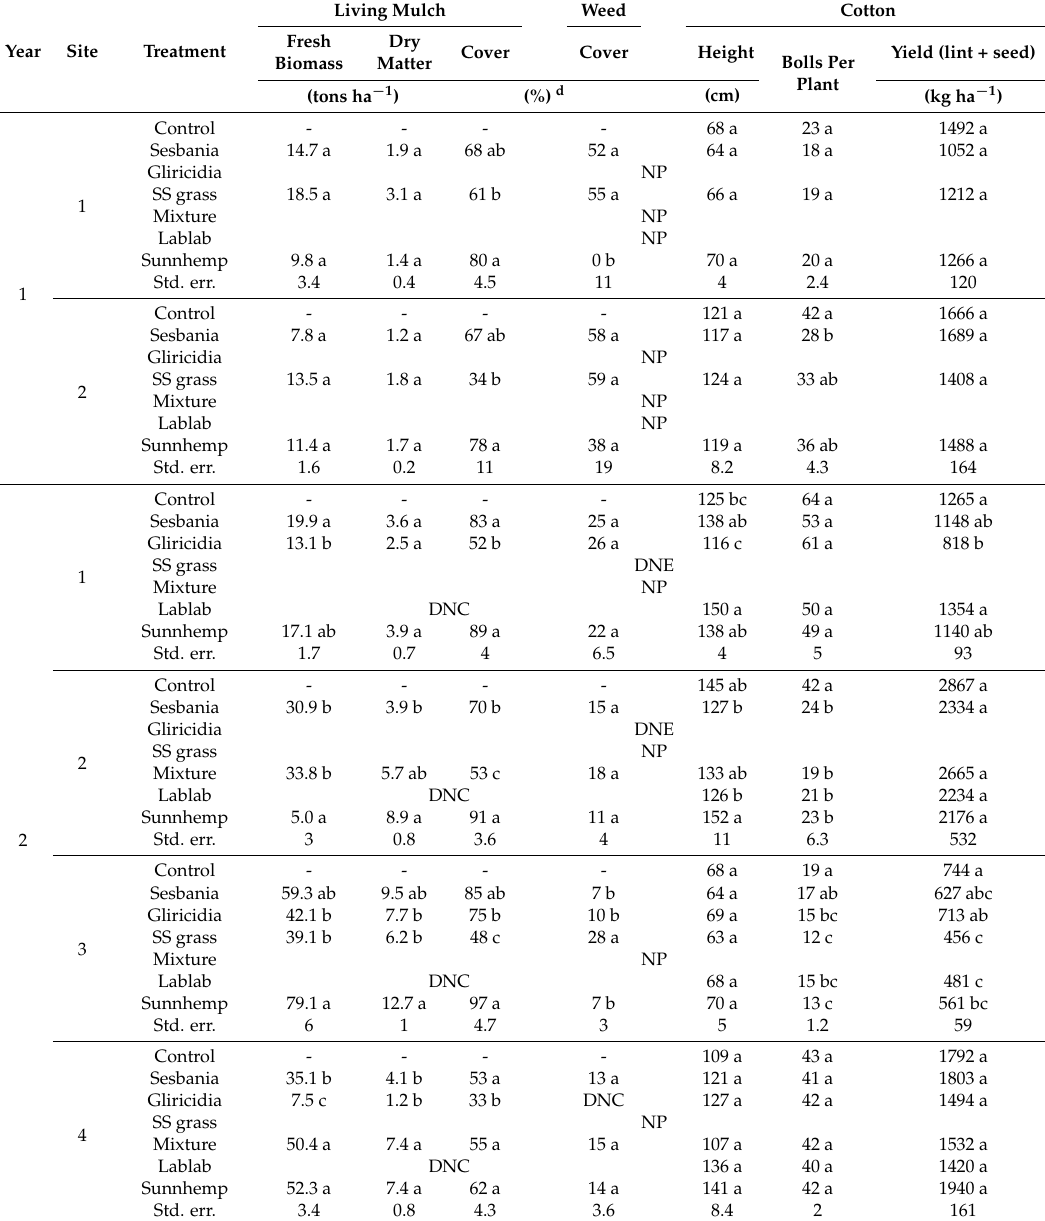
Table 6. Cotton, living mulch and weed parameters at each site-year a,b,c